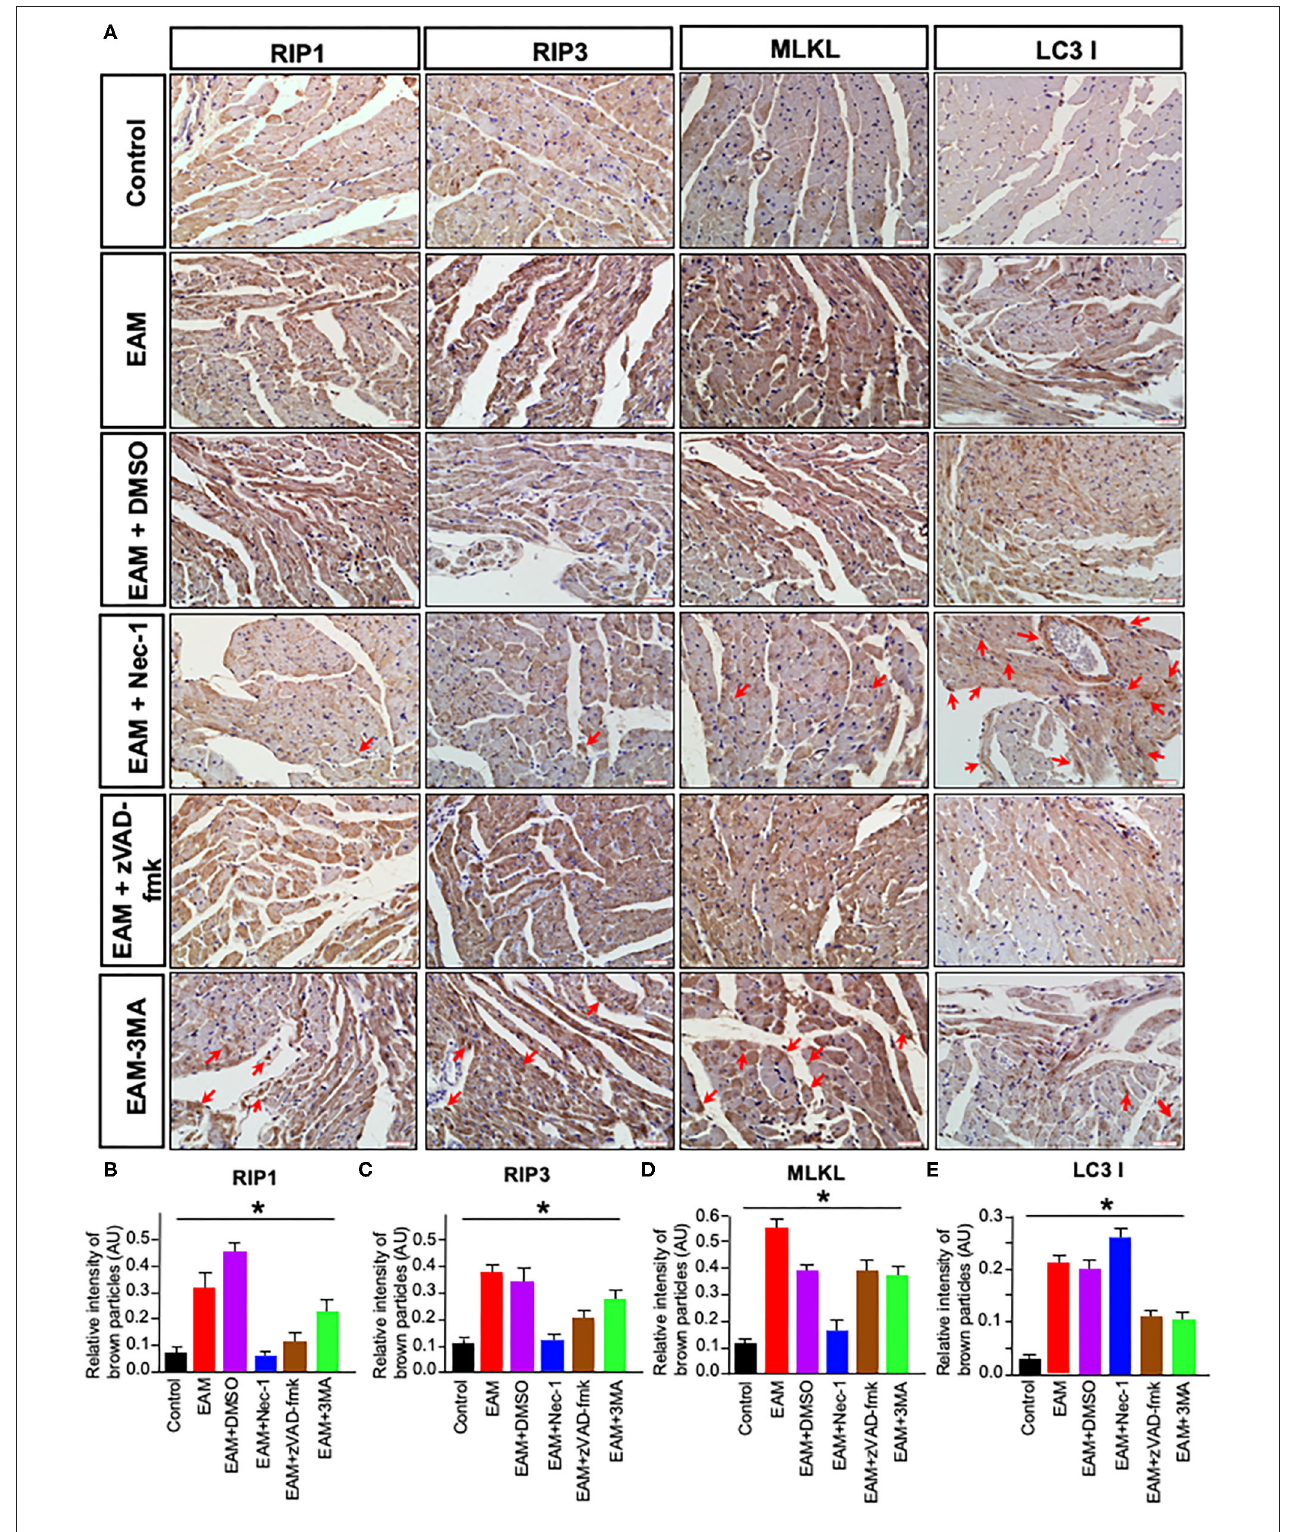
FIGURE 7 | Immunohistochemical staining of RIP1/RIP3/MLKL and LC3B in rat myocardium. (A) Imunohistochemistry staining images of RIP1/RIP3/MLKL and LC3B. Red arrows point the brown particle deposition. Control: control group; EAM: EAM (3W); IMM + DMSO; EAM + Nec-1: necroptosis inhibitor group; EAM-zVAD-fmk, apoptosis inhibitor group, EAM + 3-MA: autophagy inhibitor group. RIP1, RIP3, MLKL, and LC3B. (B–E) Quantity of brown–red particles’ intensity in